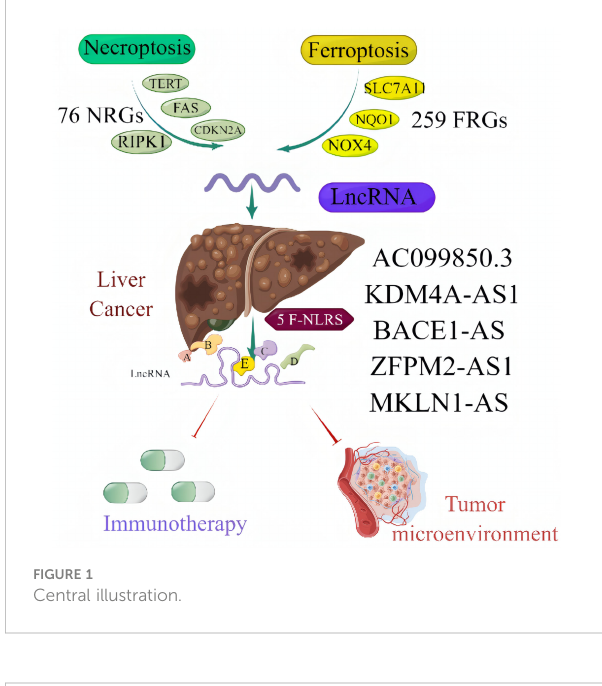
FIGURE 1 Central